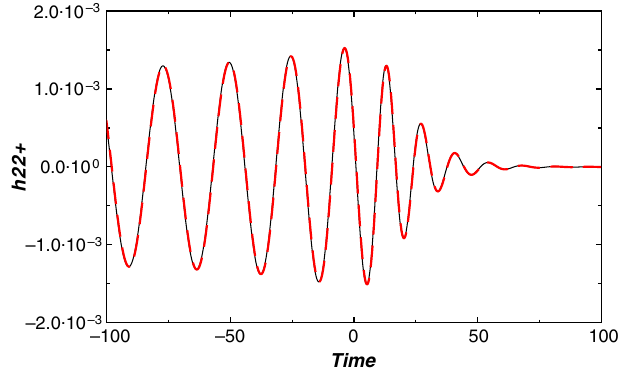
FIG. 2. The waveform emitted during the final plunge phase of the EMRI inspiral with the largest gravitational radiation